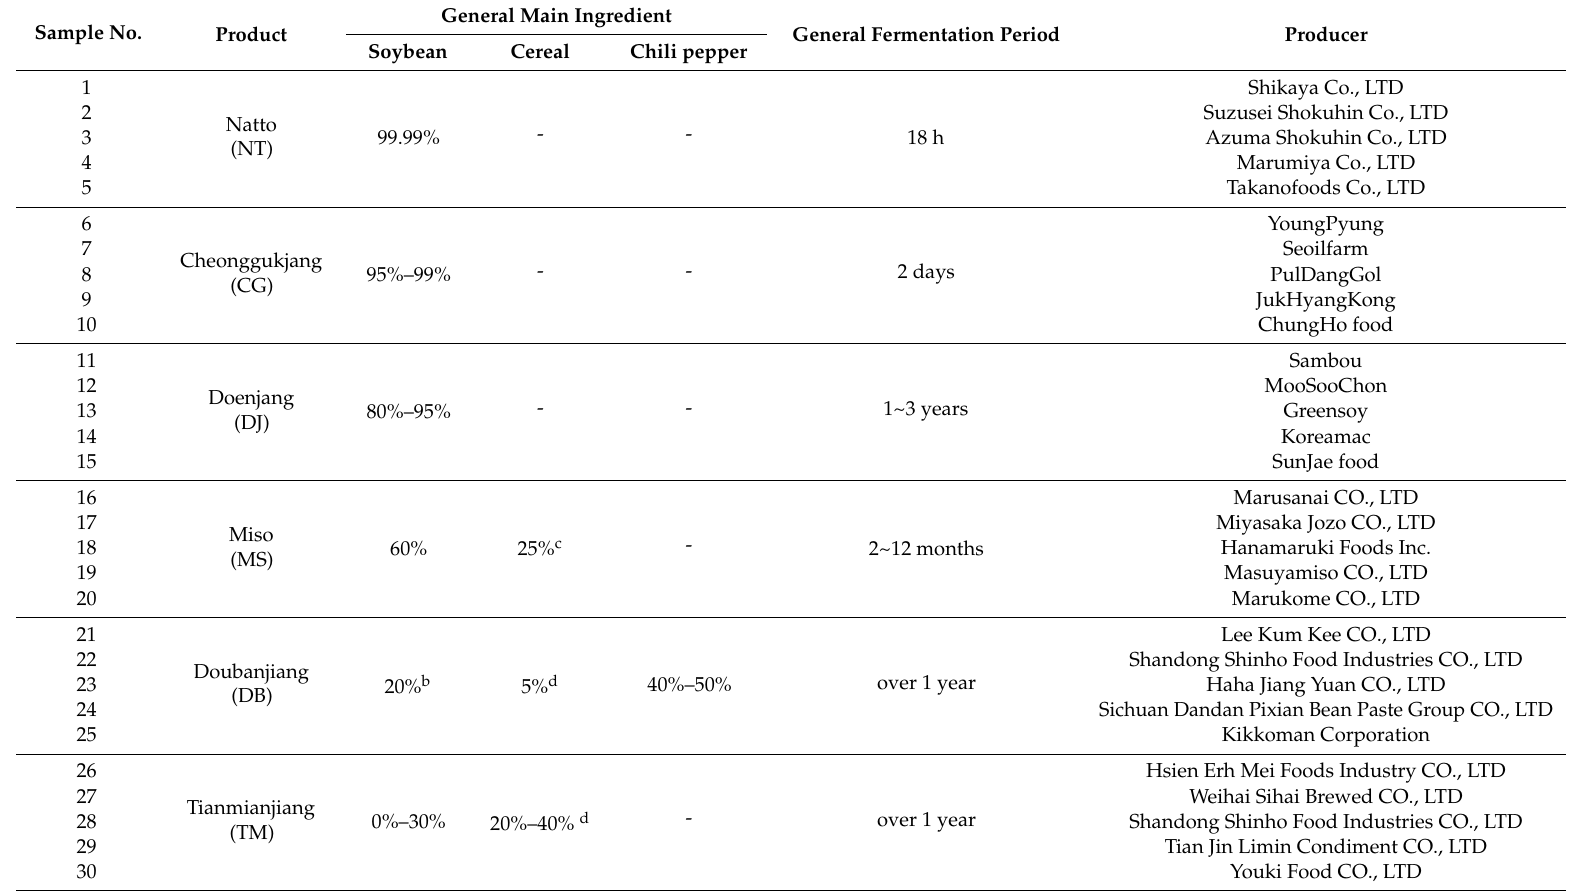
Table 1. Information for the six kinds of FSPs a